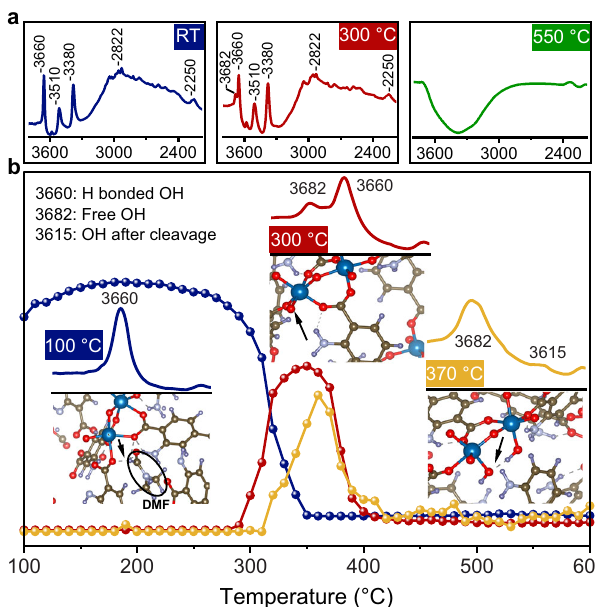
Fig. 4 In situ DRIFTS study of 10%NH 2 -MIL during heating up to 600 °C. a Example spectra taken at room temperature (RT), 300 °C and 550 °C. b Selected IR bands and their corresponding thermal evolution plots. The insets show a schematic representation of the structural feature as revealed by DFT simulations: the bands correspond to OH groups that are H-bonded to trapped DMF molecules (3660 cm − 1 ), free OH groups formed after DMF removal (3682 cm − 1 ), and OH groups formed after partial or complete cleavage of the BDC-NH 2 linker from the cluster (3615 cm − 1